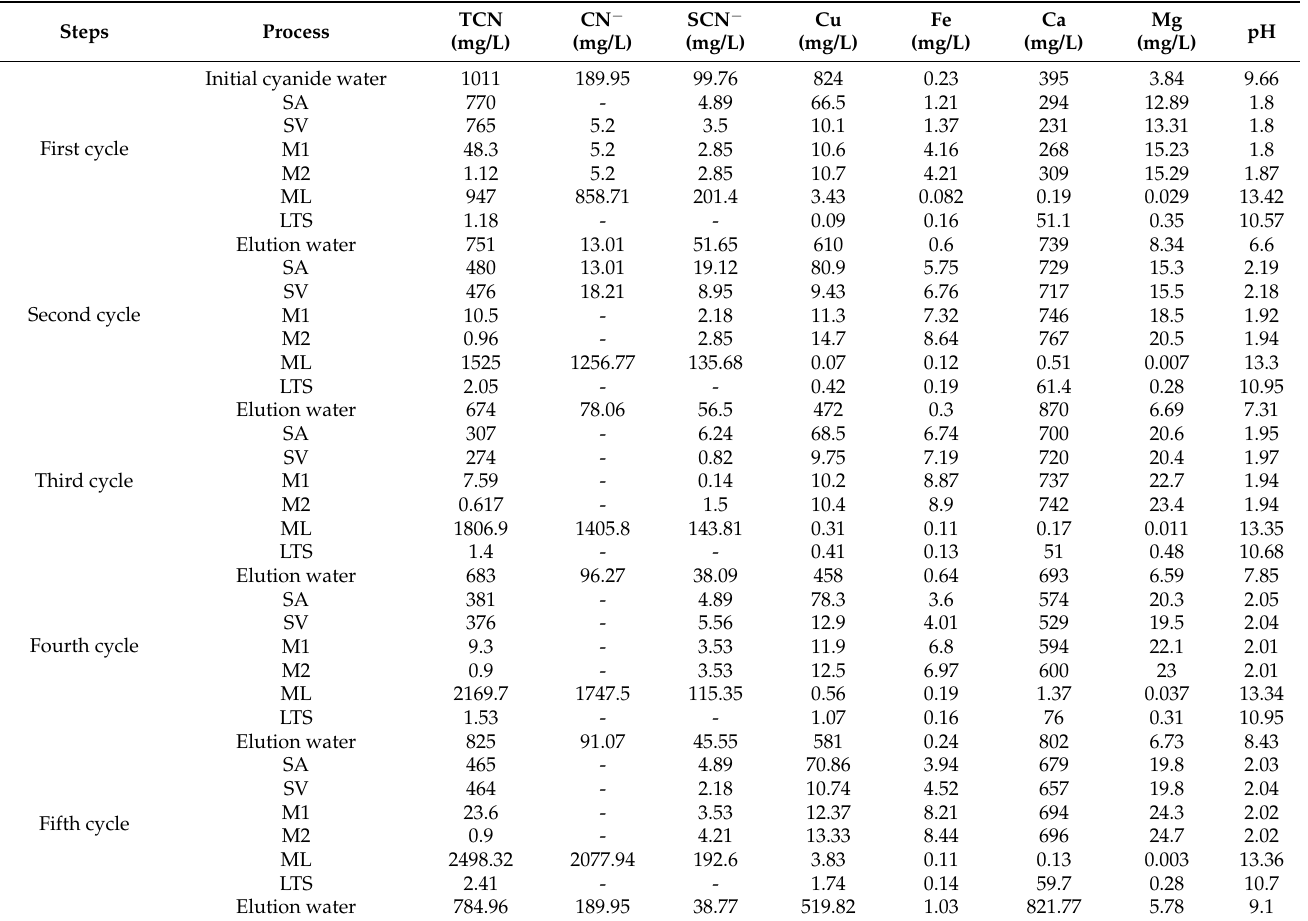
Table 4. Results of the circulation